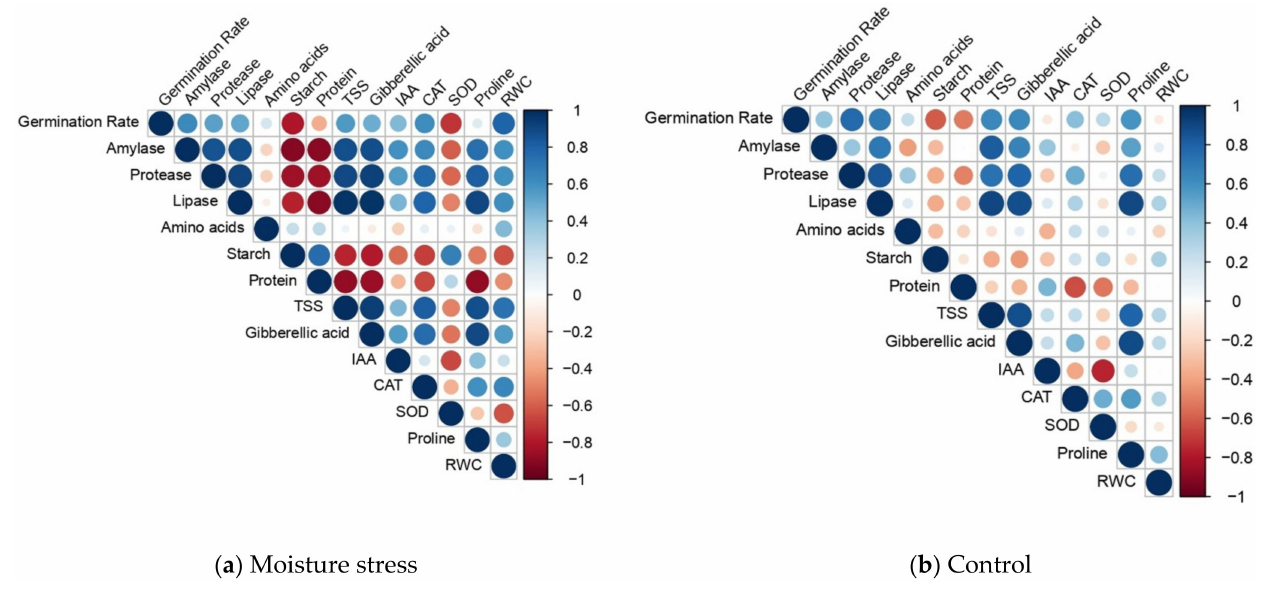
Figure 8. Correlation between morpho-physiological characteristics, phytohormone modulation and antioxidant enzymes in response to induced oxidative stress in selected rice genotypes: ( a ) S—induced moisture stress of − 1.5 MPa; ( b ) C—controlled